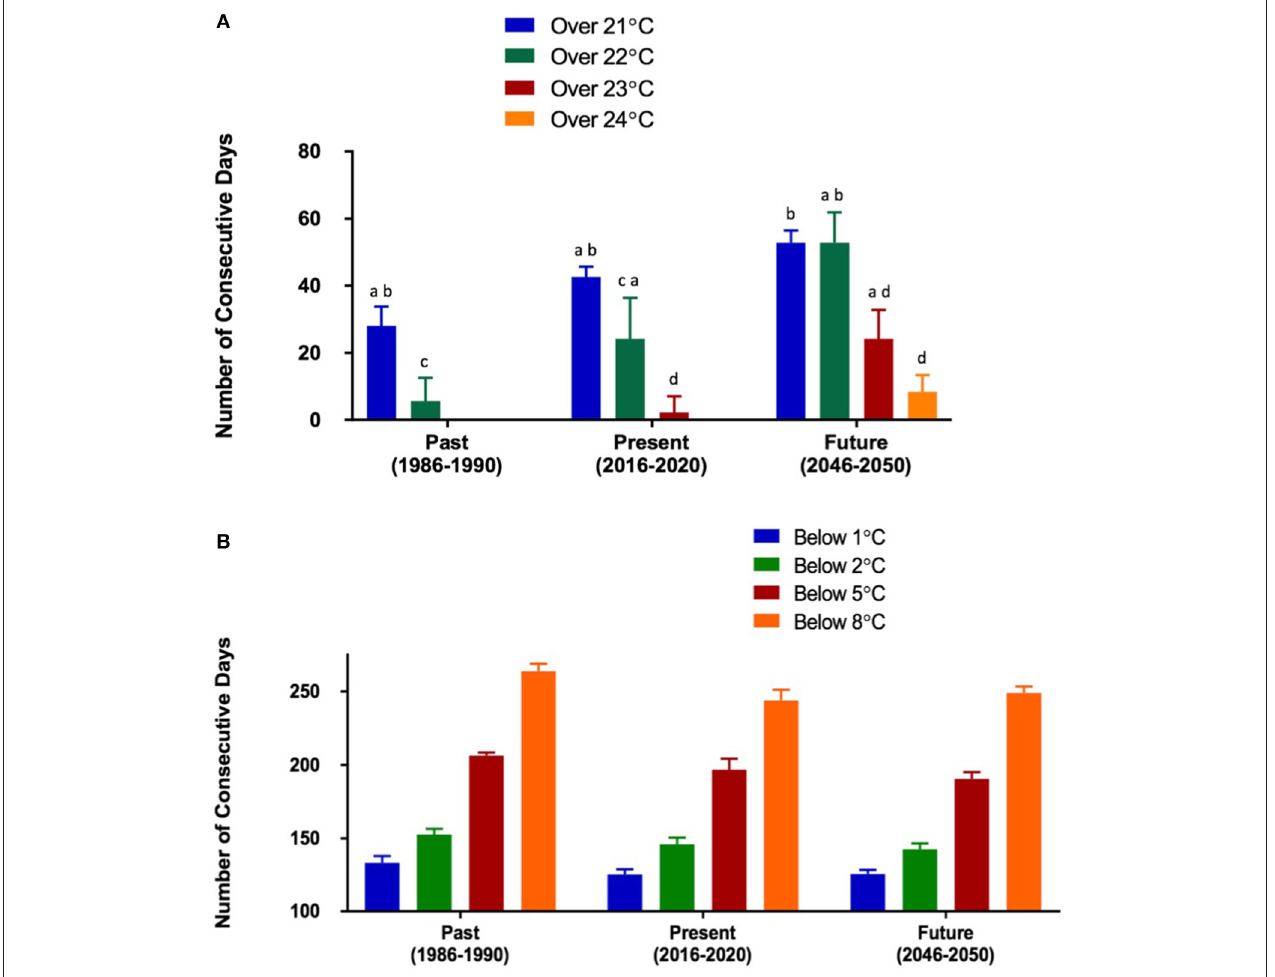
FIGURE 2 | (A) Number of consecutive days that exceeded M. edulis’ upper thermal threshold (21 ◦ C) (Rosland et al., 2009). Temperature data was taken from the warmest coastal pixel within the model domain. Bars not sharing the same letter indicate significantly different groups ( p < 0.05). (B) Number of consecutive days falling below C. virginica’s lower thermal threshold (8 ◦ C) ( Lavaud et al., 2017). Temperature data was taken from the coldest coastal pixel in the model domain. Within each temperature group, no significant effect of time was found ( p >